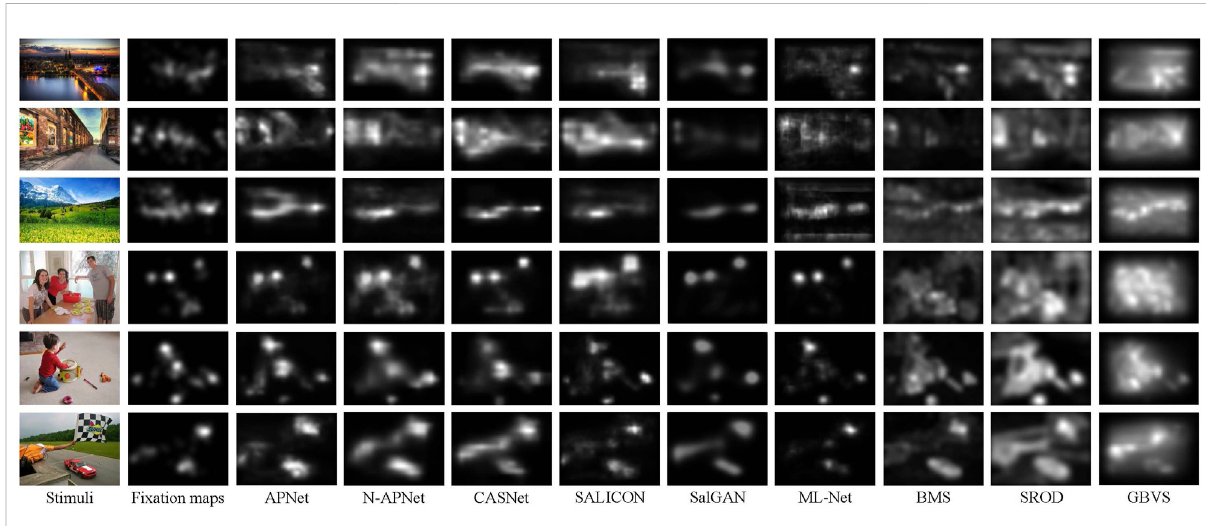
FIGURE 5 Visual comparisons of results generated by our saliency model with state-of-art methods. Our model (APNet) outperforms others in both location and order, by taking into consideration color prioritization effects in attention allocation within an